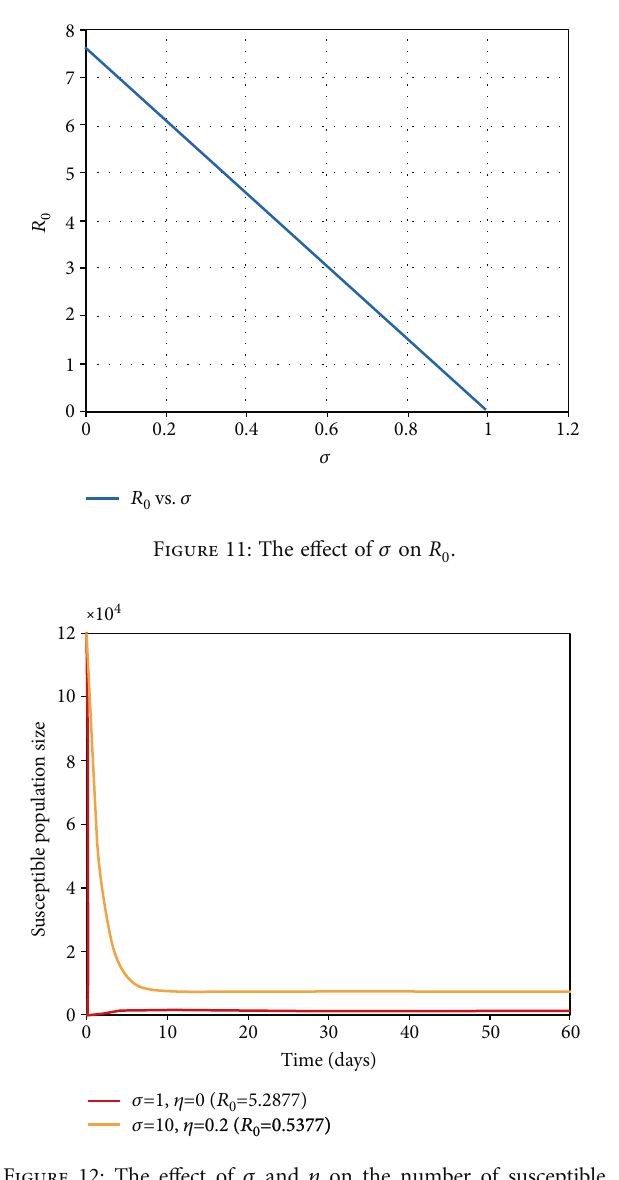
Figure 12: The e ff ect of σ and η on the number of susceptible population.